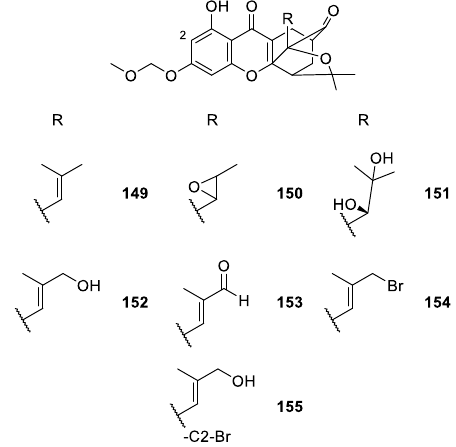
Figure 13. Structures of caged xanthones 139 – 148 , with antitumor activity.